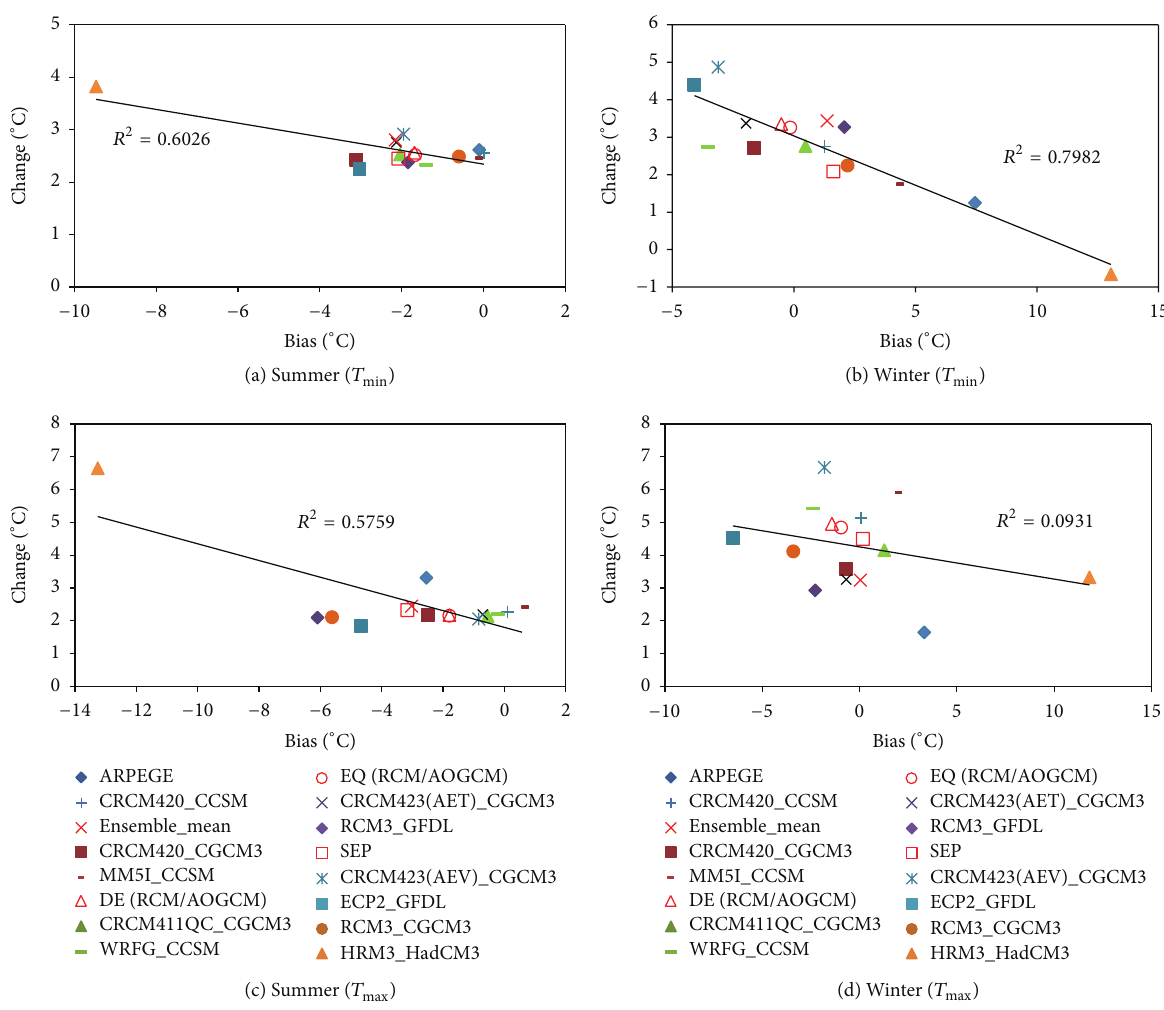
over the study region. Note that the signals were rescaled as percentages for precipitation and absolute values (i.e., ∘ C) for 𝑇 𝑇 min and max